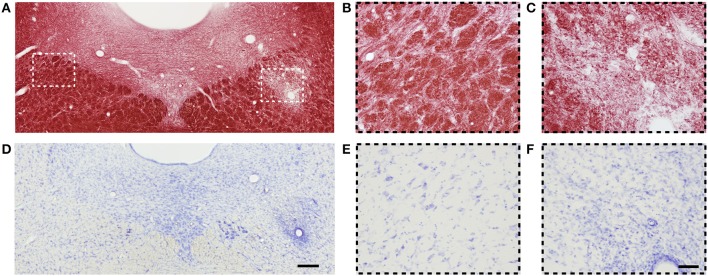
(A) Representative photomicrograph of myelin-stained sections of the dorsal tegmental tract. (B,C) are high magnification images of contra- and ipsilateral ROIs from (A), respectively. (D) Representative photomicrographs of Nissl-stained sections of the dorsal tegmental tract. (E,F) are high magnification images of contra- and ipsilateral ROIs from (D), respectively. Scale bars: (D,F) 200 and 50 μm, respectively.